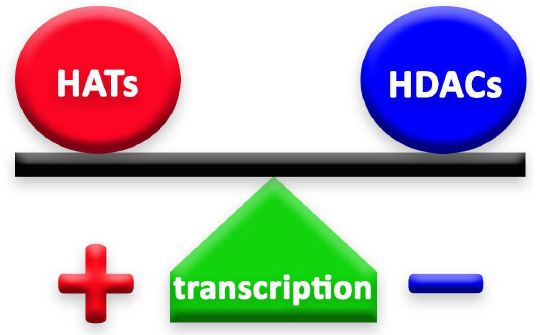
Figure 1. The balance between HATs and HDACs is crucial to the well-being of cells and organisms. The action of HDACs lowers gene transcription. On the contrary, when HDACs are repressed, the effect of HATs is stronger and leads to higher levels of gene transcription.